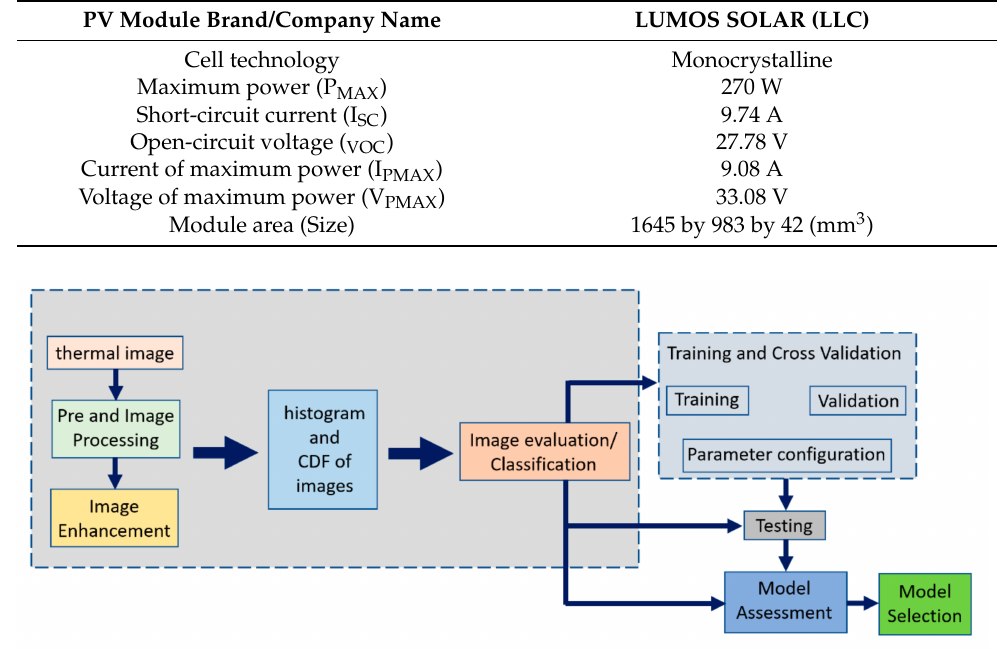
Figure 6. Processing blocks of the proposed algorithm.